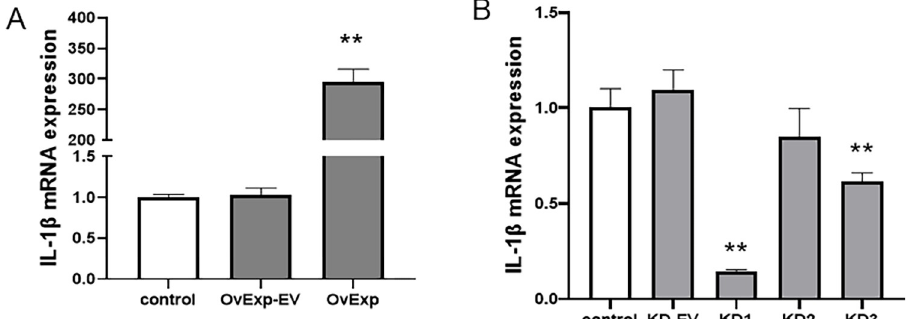
Fig 2. The efficiency of IL-1 β overexpression and knockdown. A7r5 cells were transiently transfected with the vectors for IL-1 β overexpression (A) and knockdown (B), with the related empty vector and untransfected cells as control. Cells were harvested and cell lysates were analyzed by qPCR to detect the efficiency of vectors. Results are represented as Mean ± S.E.M. �� P < 0.01 vs control (n = 5). OvExp: overexpression; OvExp-EV: overexpression empty vectors; KD-EV: knockdown empty vector; KD: knockdown